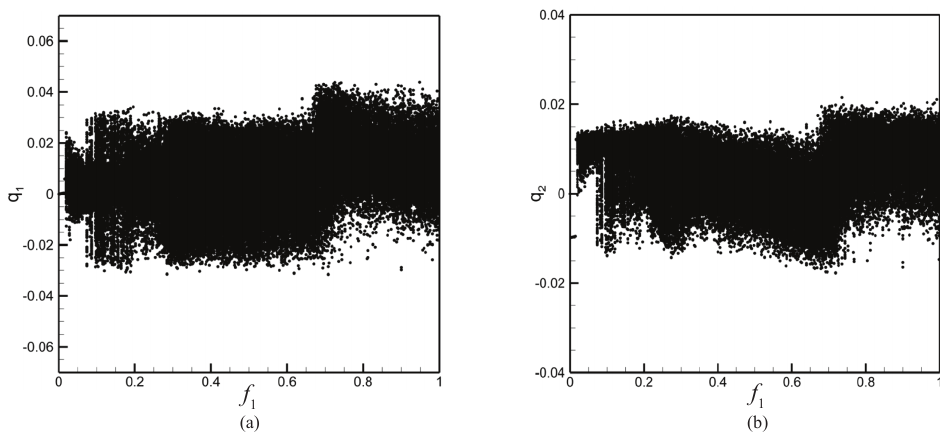
Fig. 13. Bifurcation diagrams of Poincaré points for increasing forcing amplitude on the system with c = 1 . 8 ,α = 5 and β = 1 .